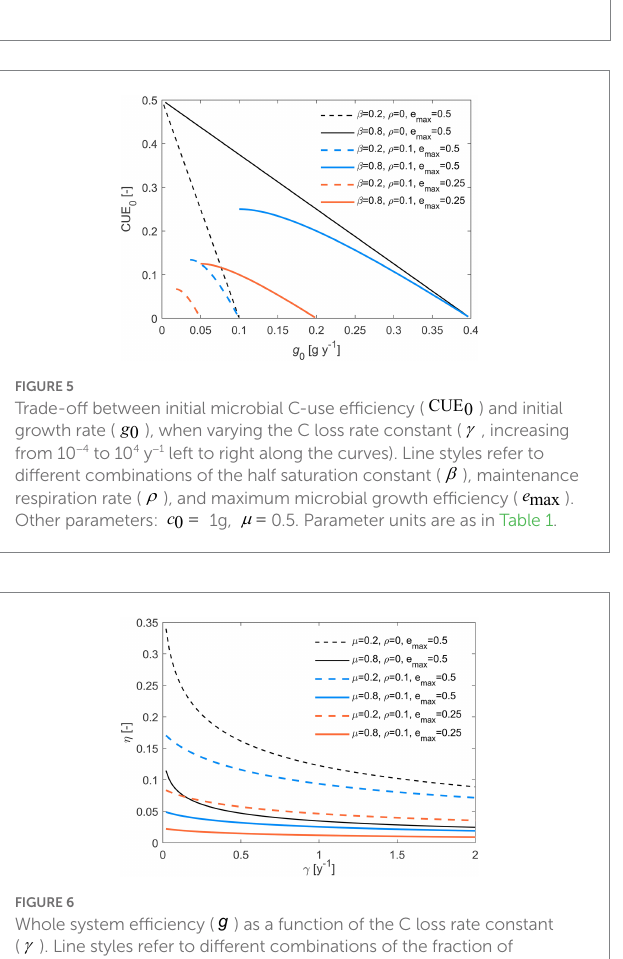
FIGURE 4 Effect of half saturation constant ( b , left column), maintenance respiration rate ( r , central column), and maximum microbial growth efficiency ( max e , right column) on initial optimal decomposition rate ( 0 u , top row) and terminal time ( t t , bottom row), for two values of the first-order decay constant ( g , dashed vs. solid) and the necromass recycling fraction ( m , black vs. blue). Other parameters: 0 c = 1 g (all panels), r = 0.1 g y − 1 (A,C,D,F) , b = 0.5 g y − 1 (B,C,E,F) , max e = 0.5 (A,B,D,E) . In (A–C) , lines with different values of m overlap because 0 u is independent of m . In all panels: 0 c = 1 g. Parameter units are as in Table 1.